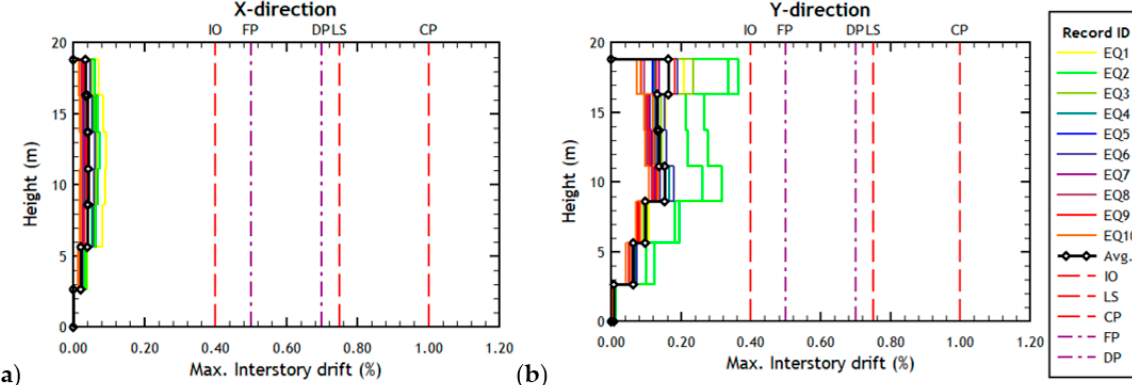
Figure 13. Maximum displacements in ( a ) X-direction and ( b ) Y-direction, as obtained from NLTHA for the records of Table 3. The results of the NLTHA show again that the building is much stiffer in the X direc- tion than in the Y direction. The interstory drifts in the X direction are considerably lower than the thresholds set by both the ASCE SEI 41-17 and the ACHISINA Manual. On the contrary, the IO limit set by ASCE SEI 41-17 was overcome under some of the earthquakes in the Y direction. In the same direction the limit given by ACHISINA for buildings with fragile partitions is reached under the strongest earthquake of the set. Since, however, both ASCE SEI 41-17 and ACHISINA Manual allow considering the values of displace- ments and drifts averaged over the ten earthquakes of the set, it is of note that the code limits are safely respected in the two directions when the averaged results are considered. This highlights an overall good performance of the structure.